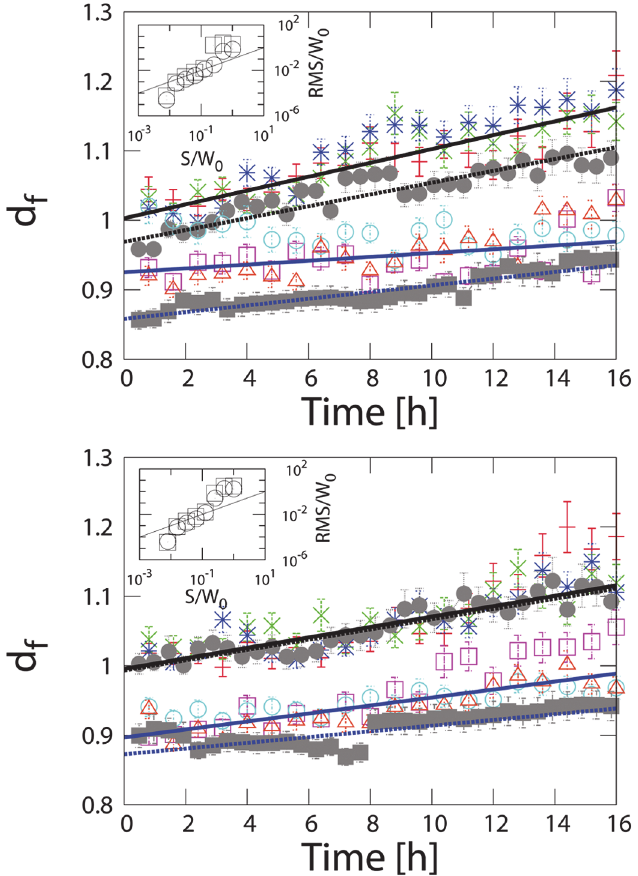
Fig 2. Time evolution of the effective fractal dimension d f for (a) the left and (b) the right cell monolayer-wound interface. The structure of the cell monolayer-wound interface of the ko cells ( □ , 4 , (cid:5) , d f shifted by-0.1 for a better visibility) evolves significantly slower compared to the ctr cells (+, ×, □ ). Simulations (filled symbols) agree with the experimental data. The solid and dashed lines fit the experimental and simulation data, respectively. The insets show the root mean square deviation (RMS) 12 hours after scratching, normalized by the initial wound width W (0) for both the experiment mKC ctr 2 ( □ ) and the corresponding simulation ( (cid:5) ). The solid lines are power laws with exponent 1, i.e. roughness φ = 1. The size of the error bars represents the variability of the data within two standard